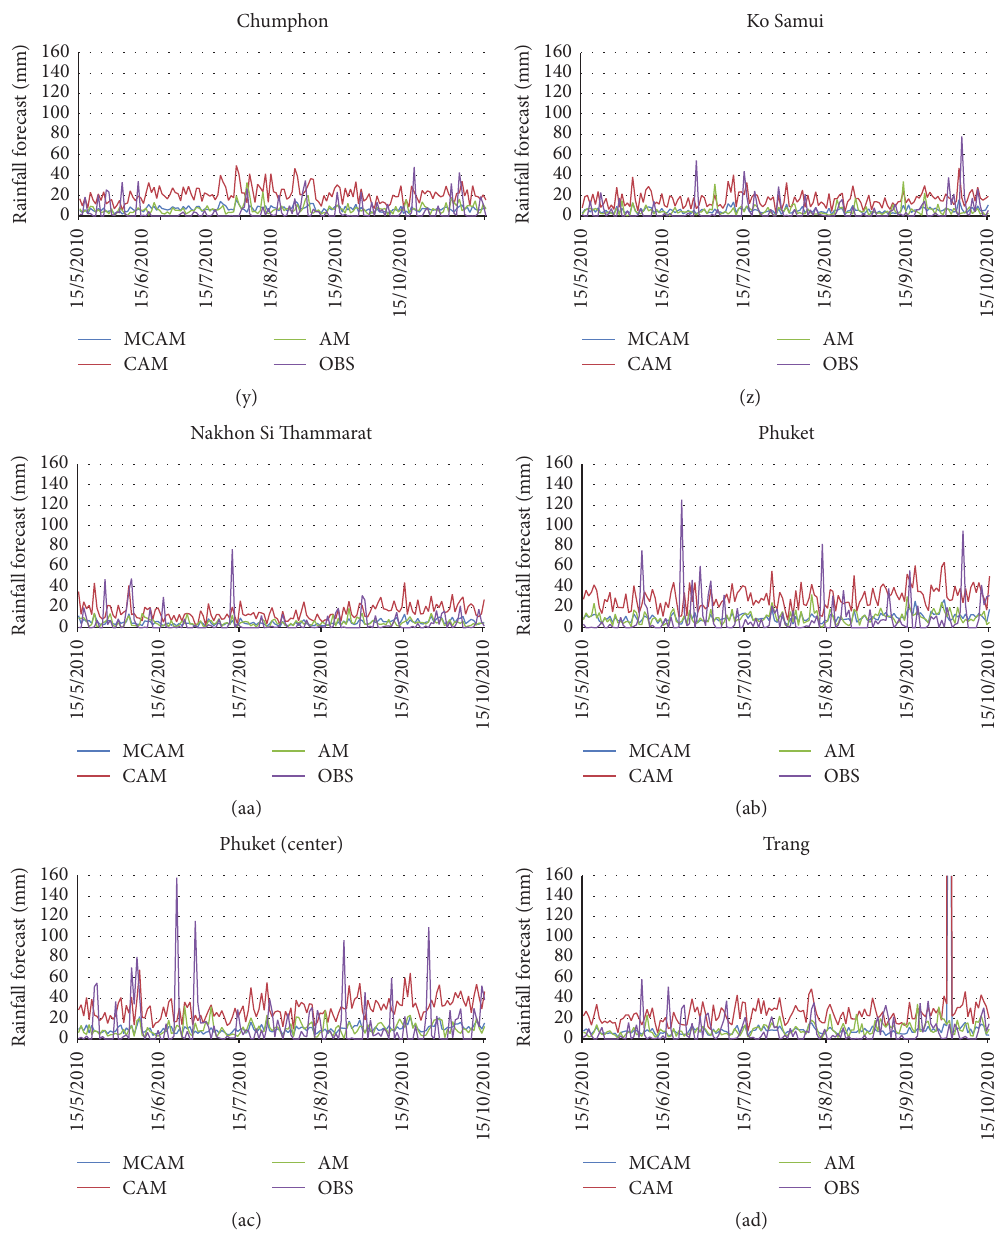
Figure 16: Time (day) during 15 May to 15 October